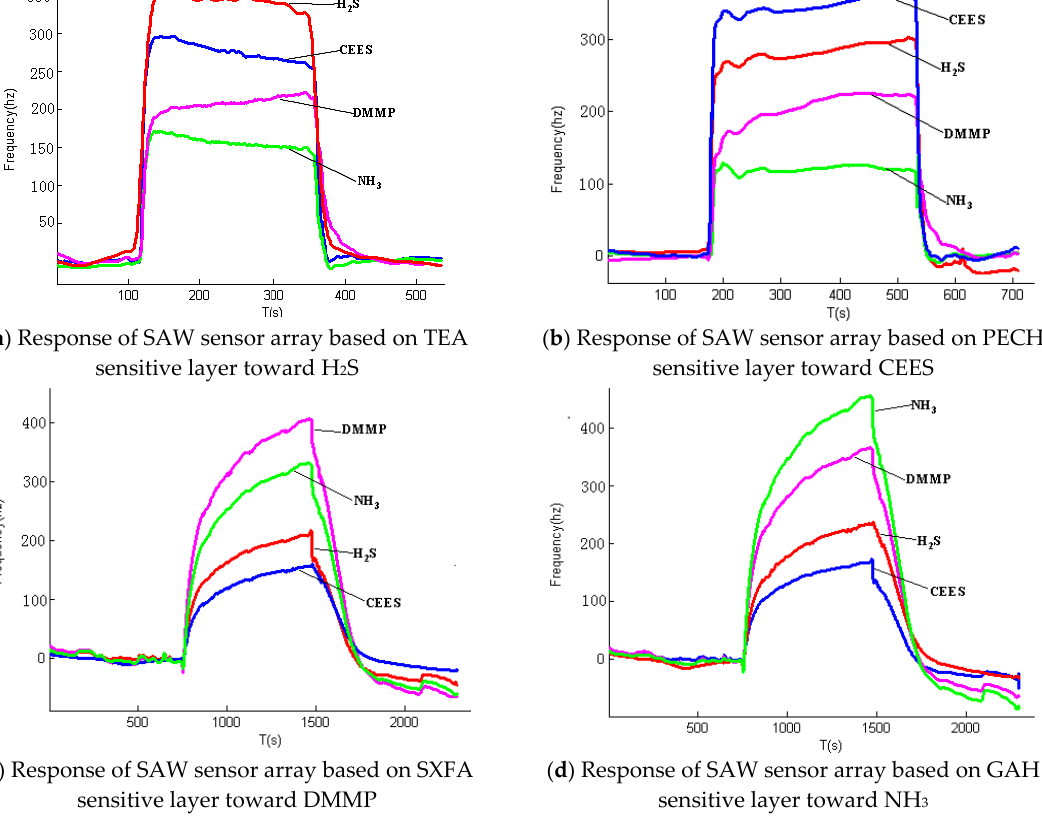
Figure 7. Detection results of the SAW sensor array to different gases.